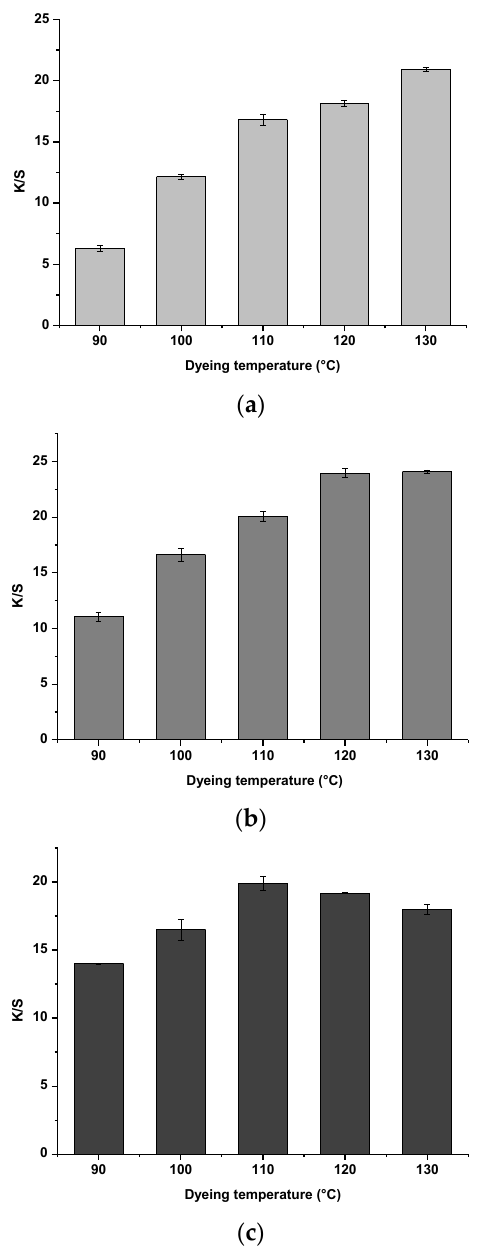
Figure 8. Effect of dyeing temperature on the color yield (K/S) of bicomponent filaments dyed with: Figure 8. E ff ect of dyeing temperature on the color yield (K / S) of bicomponent filaments dyed with: ( a ) Dye #H; ( b ) Dye #M; ( c ) Dye #L (pH = 7, Carrier concentration = 0 g/L, Time = 50 min). ( a ) Dye #H; ( b ) Dye #M; ( c ) Dye #L (pH = 7, Carrier concentration = 0 g / L, Time = 50 min). Results obtained for the high energy dye, CI dye Disperse Red 167.1, show that increasing the ◦ ◦ dyeing temperature from 100 C to 130 C significantly increases the color strength (K / S). In fact, as the results of thermal analysis show (DSC), the relatively high glass transition temperature of ◦ PET / PTT bicomponent filaments (Tg = 39.27 C) and the two melting temperatures of PTT and PET ◦ ◦ (Tm = 223.25 C and 247.27 C, respectively) obtained with DSC analysis indicate that the dyeing